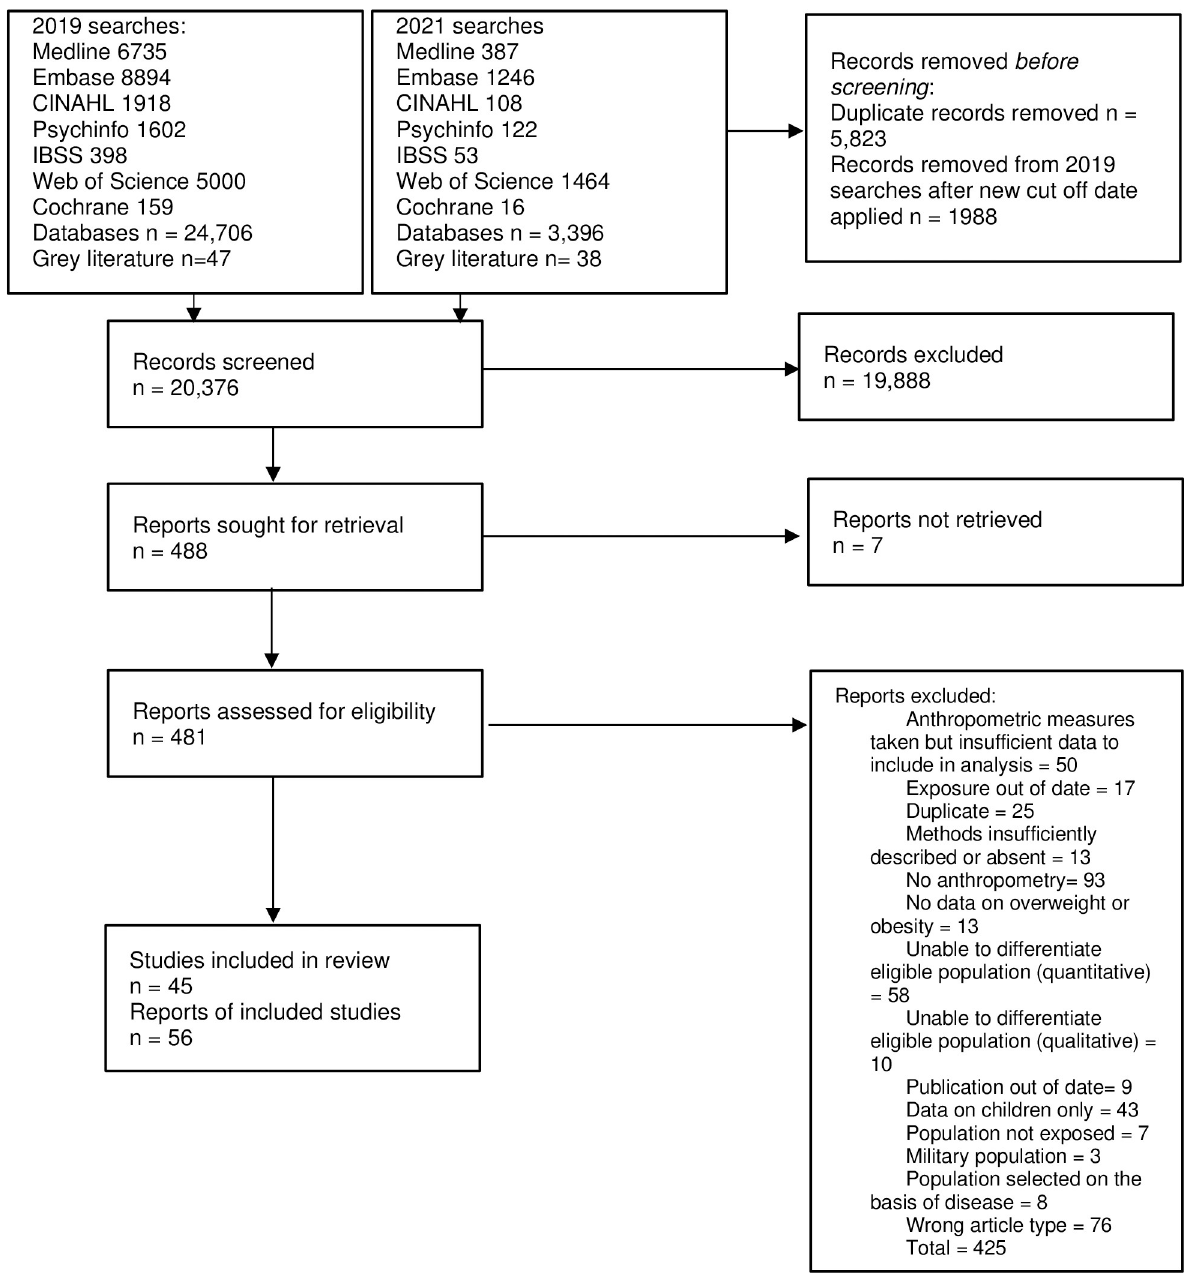
Fig 1. Showing the PRISMA flow diagram. From : Page MJ, McKenzie JE, Bossuyt PM, Boutron I, Hoffmann TC, Mulrow CD, et al. The PRISMA 2020 statement: an updated guideline for reporting systematic reviews. BMJ 2021;372:n71. doi: